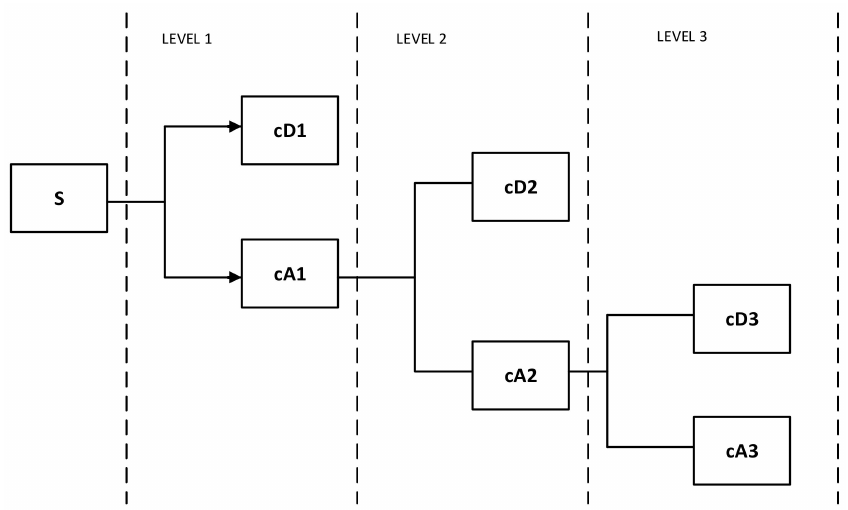
Figure 1. MRA decomposition